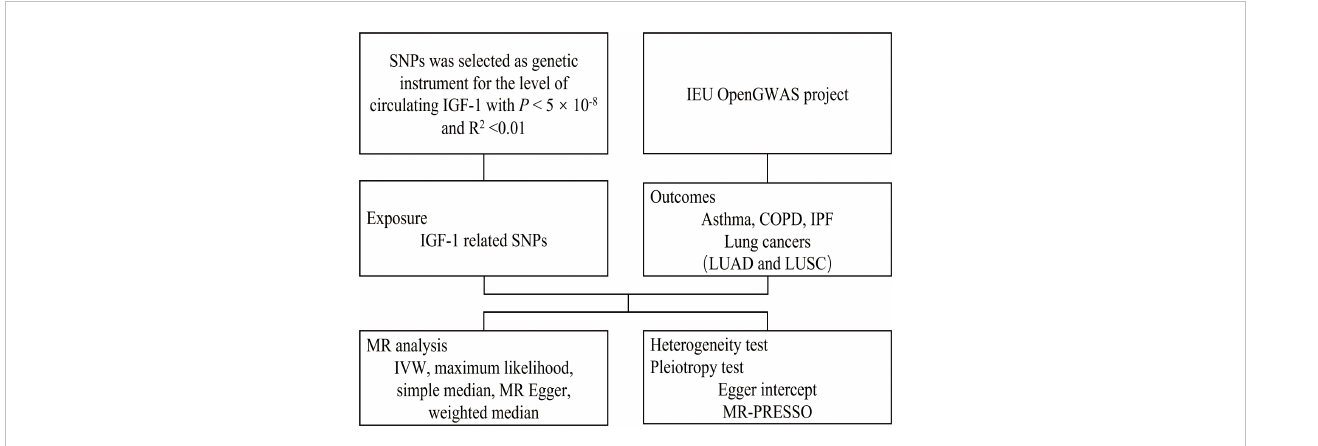
FIGURE 1 Flow chart of Mendelian randomization in this